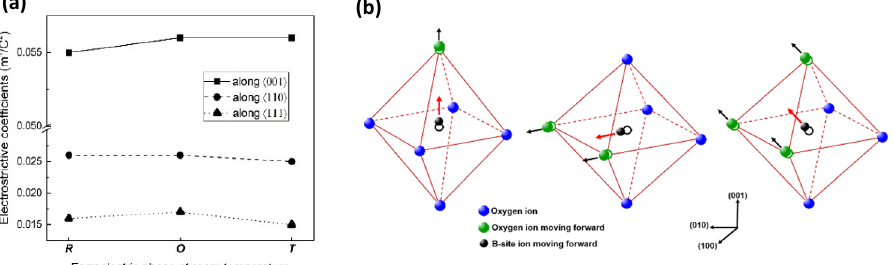
Figure 7. ( a ) Calculated longitudinal electrostrictive coefficients along (cid:104) 111 (cid:105) , (cid:104) 110 (cid:105) , and (cid:104) 100 (cid:105) direc- tions for rhombohedral, orthorhombic and tetragonal phases [40]. ( b ) Oxygen ion displacement in octahedral structure with three different polarization directions: <001> (left), <110> (middle) and <111>